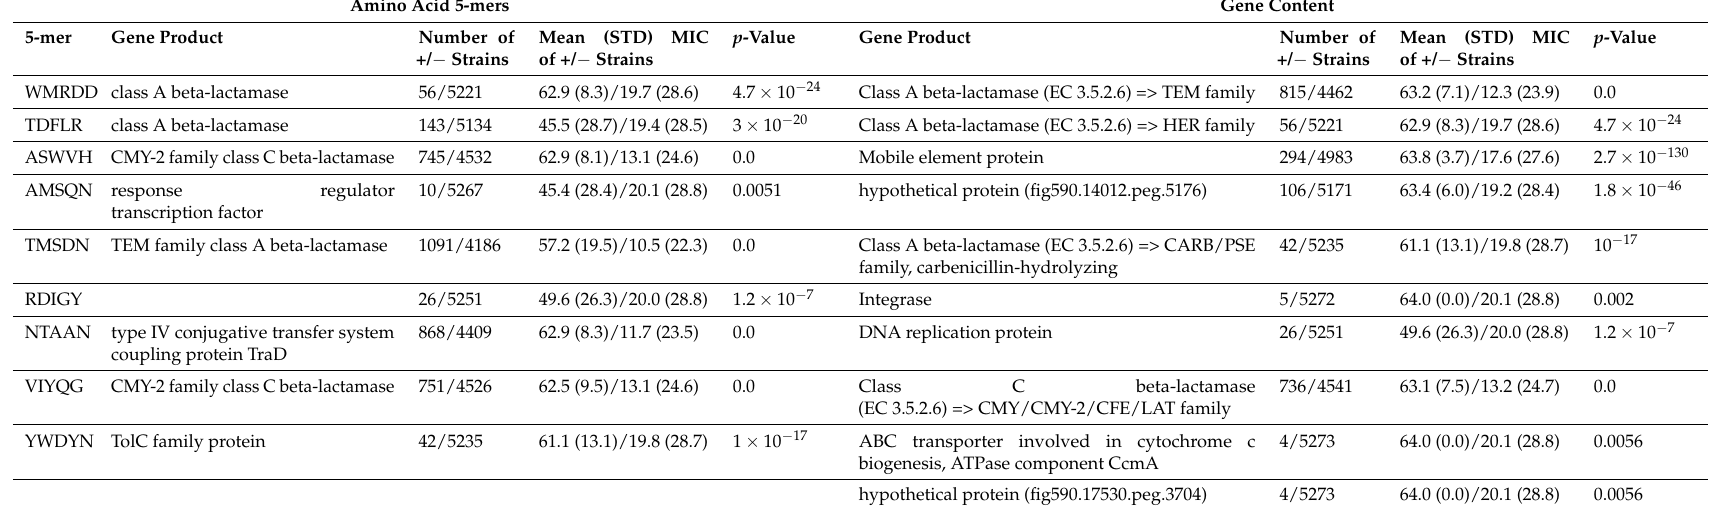
Table A9. Important genes found for S. enterica and ampicillin by amino acid 5-mer and gene content